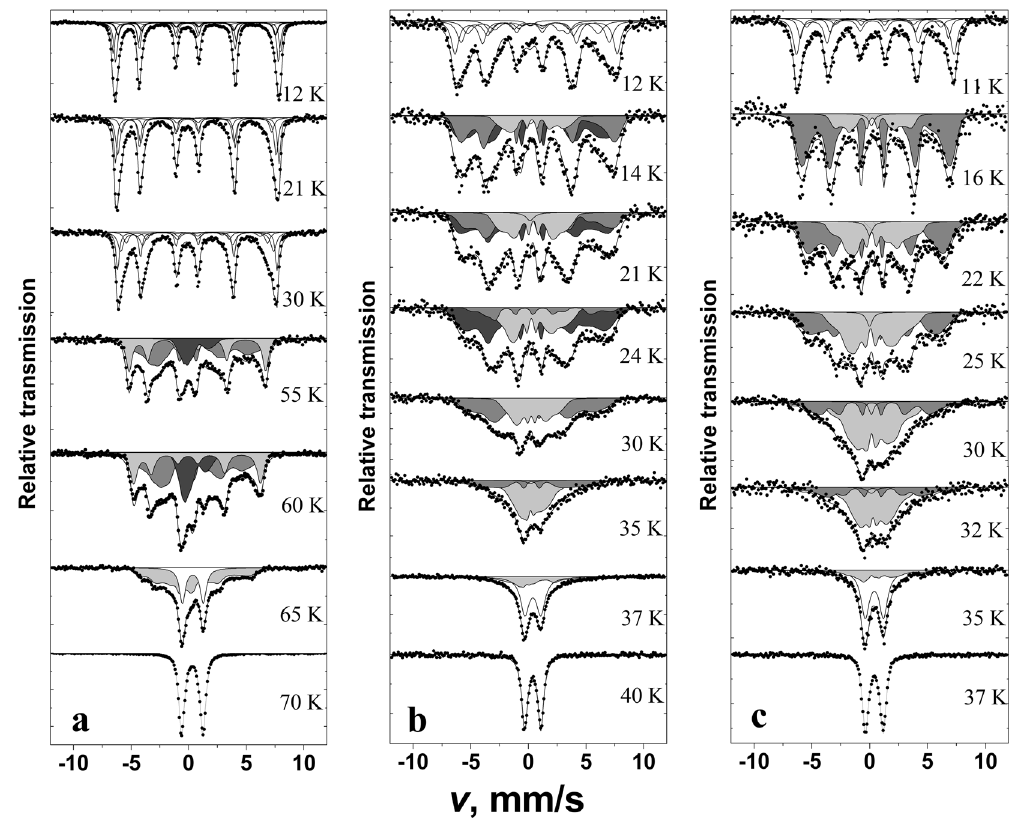
Figure 8. Mössbauer spectra of YMn 0.97 Fe 0.03 O 3 ( a ), Y 0.4 Gd 0.6 Mn 0.97 Fe 0.03 O 3 ( b ) and GdMn 0.97 Fe 0.03 O 3 ( c ) at indicated temperatures. Fitting of the spectra was performed using WinNormos-for-Igor software package (version 3.0, http://www.wisse l-gmbh.de).